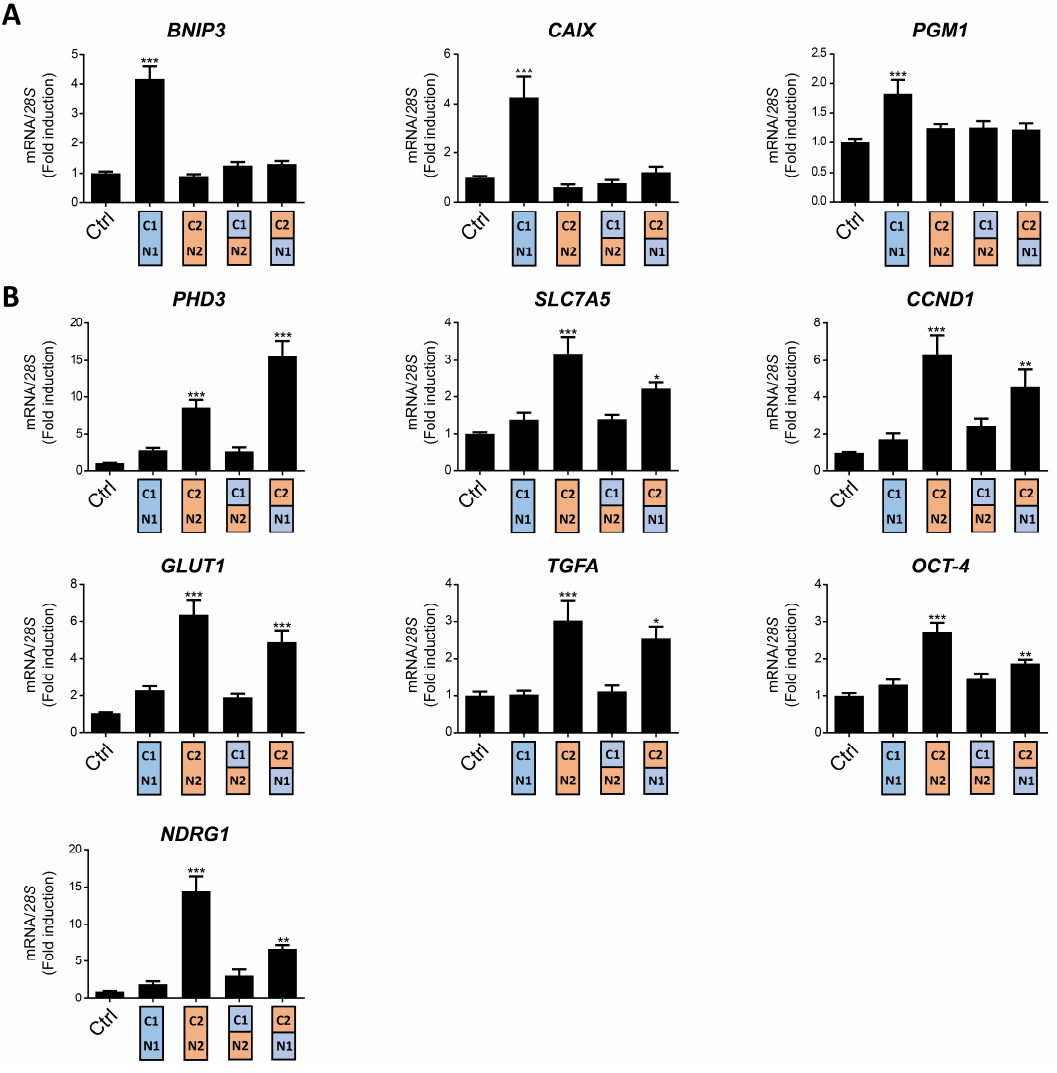
Figure 2. Target gene specificity for HIF1α(P-A) 2 , HIF2α(P-A) 2 and the HIF(P-A) 2 (N2/C1), HIF(P- A) 2 (N1/C2) chimeric versions in WT8 cells. ( A ) Relative BNIP3 , PGM1 and CAIX gene expression